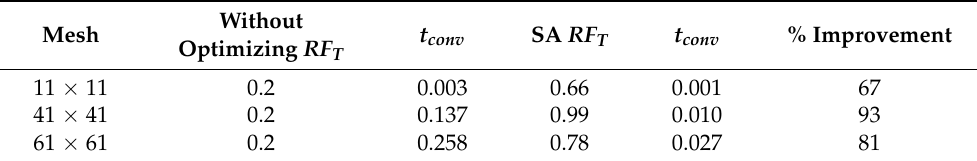
Table 5. Comparison of convergence times obtained from the convection-diffusion problem, applying RF s obtained with SA vs. RF not optimized, with different mesh sizes and a relaxed residual value of ε = 1 × 10 − 5 . Without t conv SA RF T t conv % Improvement Mesh Optimizing RF T 11 × 11 0.2